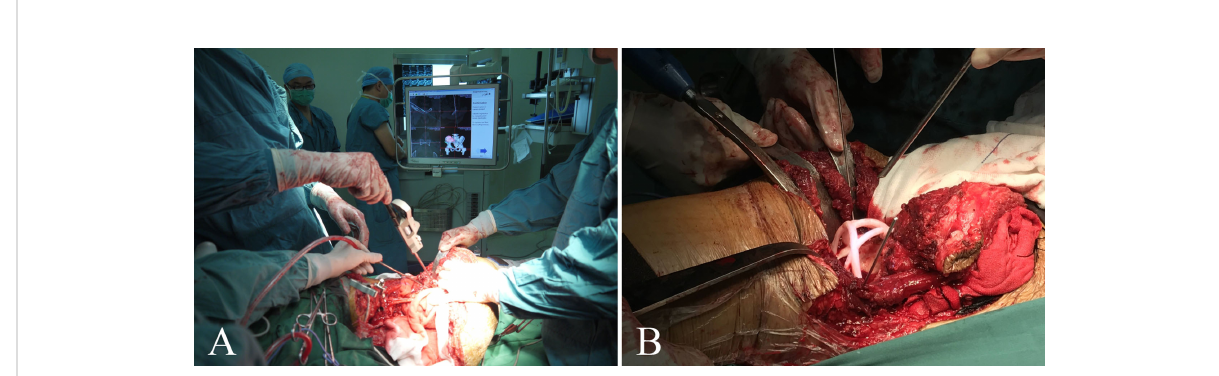
offset (FHO) indicated the distance from the rotation center of Femoral head vertical offset (FVO) indicated the vertical distance from the rotation center of the femoral head to the horizontal line passing the lowest point of the ischial tuberosity (d2 in Figure 4). Acetabular abduction angle (AAD) indicated